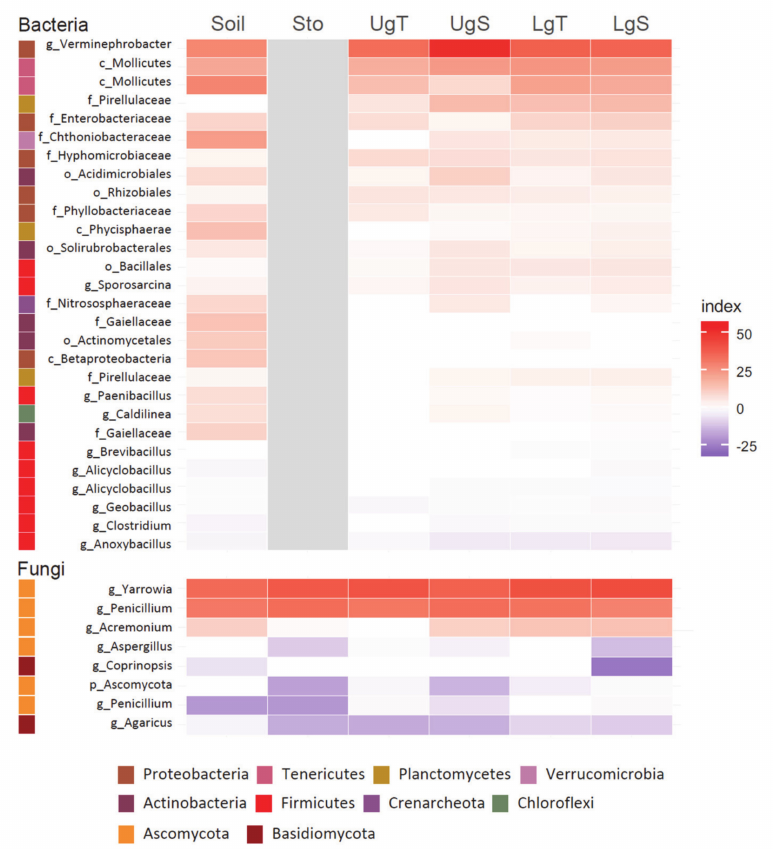
Figure 8. Heatmap of abundant and responsive bacterial and fungal OTUs of each soil and earthworm gut part that was significantly increased or depleted in the Hg-contaminated treatment in experiment 2. The heatmap was computed using the responsive index of each OTU abundance × log 2 -fold change increase or decrease in the Hg-contaminated treatment in comparison to the uncontaminated one. Sto = stomach, UgT = upper gut tissue, UgS = upper gut soil, LgT = lower gut tissue, LgS = lower gut